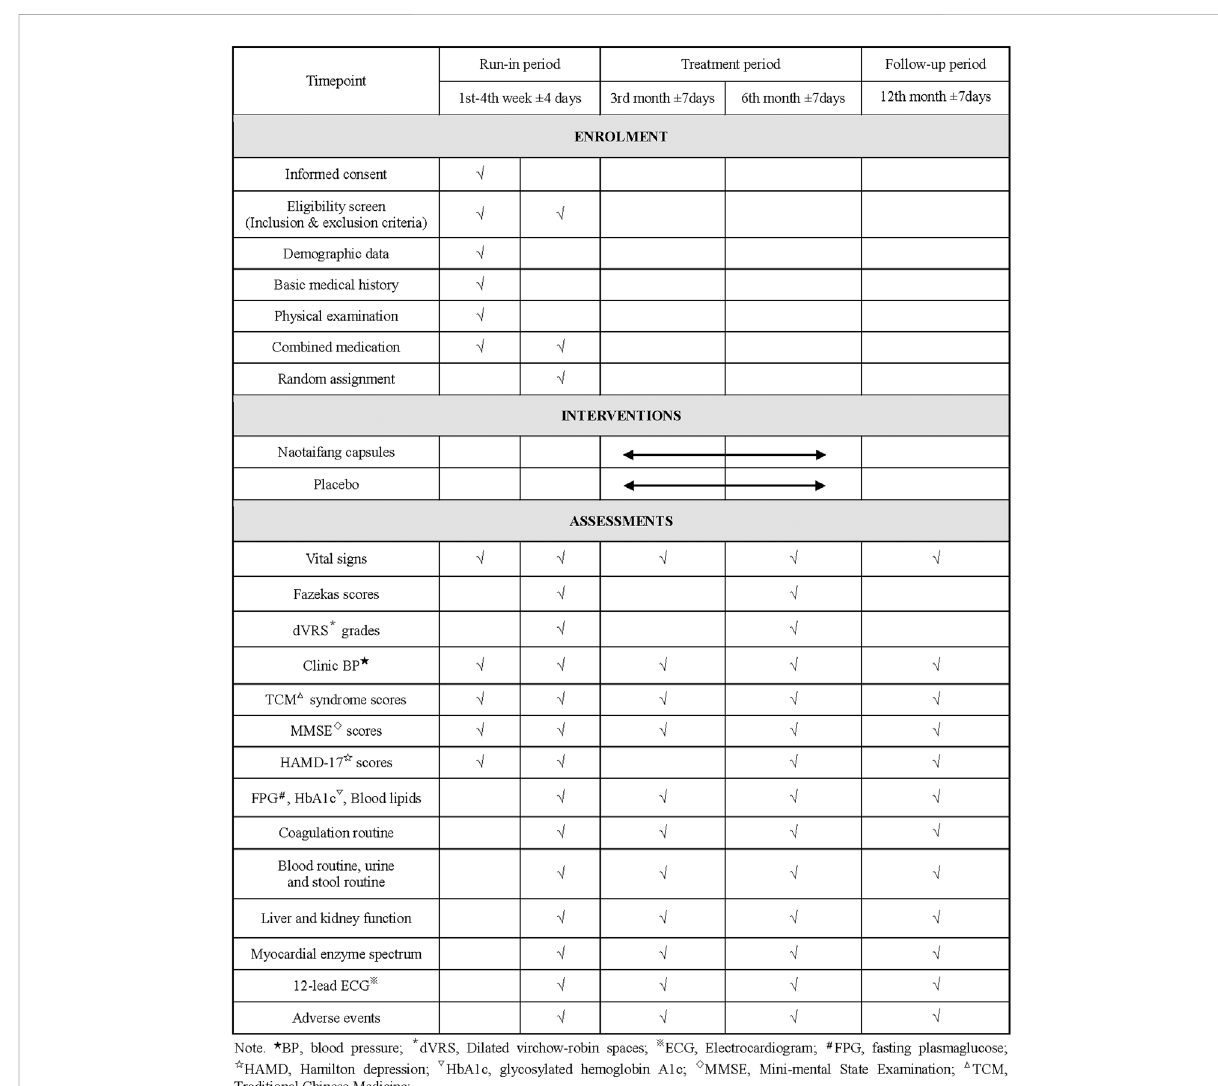
FIGURE 2 The schedule of enrollment, interventions, and